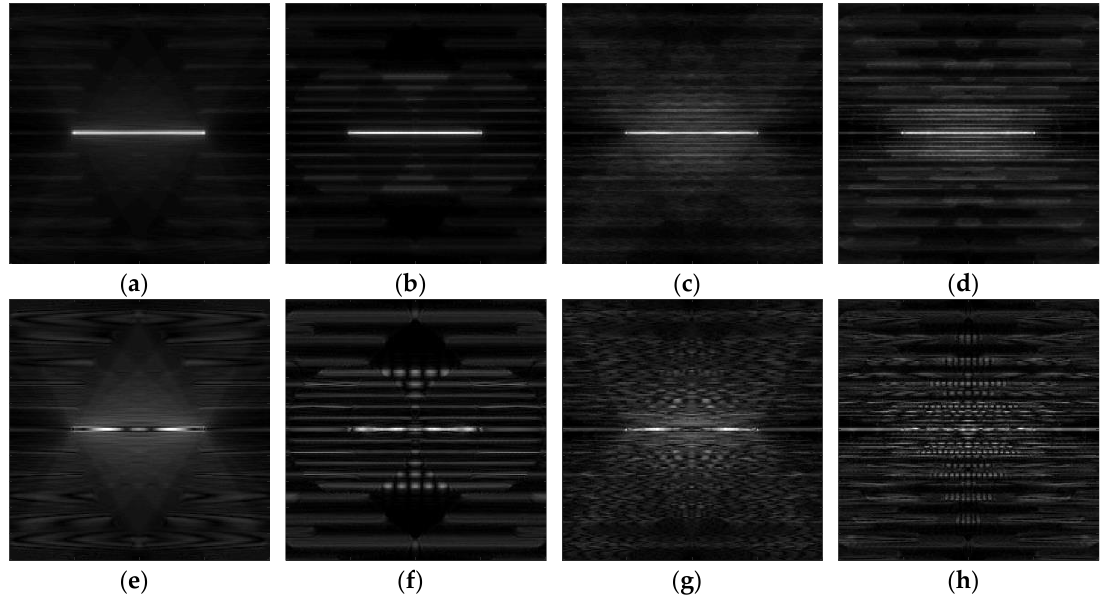
Figure 3. Single line target imaging based on gamma transformation: ( a , e ) γ = 1.2; ( b , f ) γ = 2; ( c , g ) γ = 3.5; ( d , h ) γ = 5.